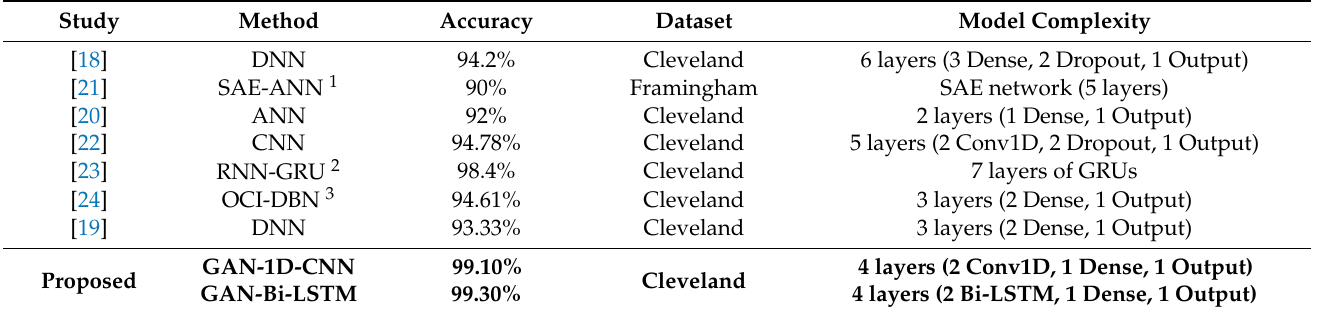
Table 9. Comparison of GAN-1D-CNN and GAN-Bi-LSTM models with